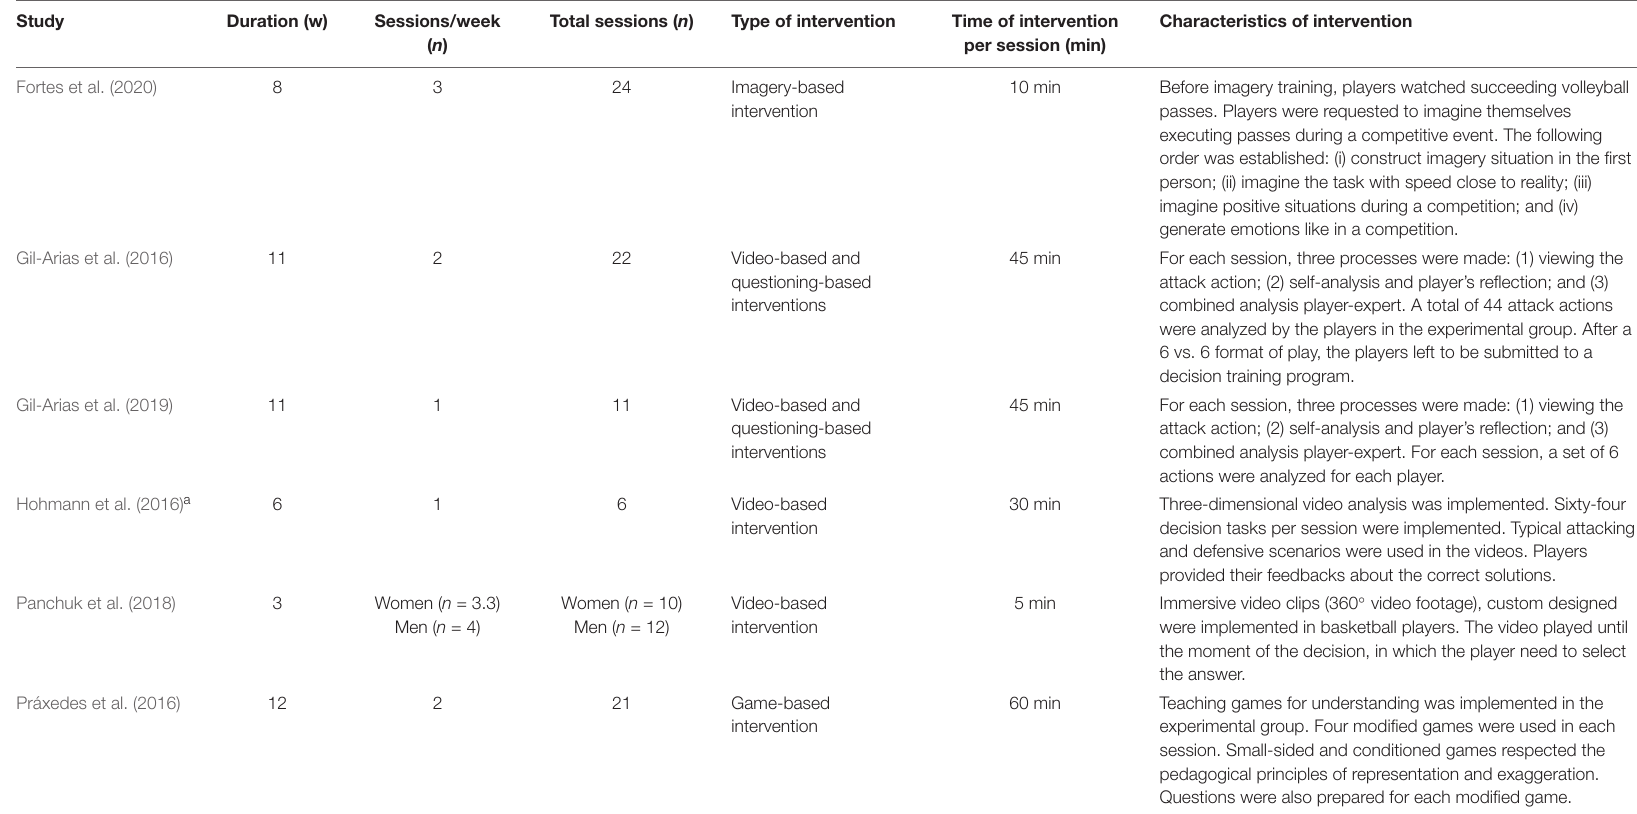
TABLE 3 | Characteristics of intervention programs in the included